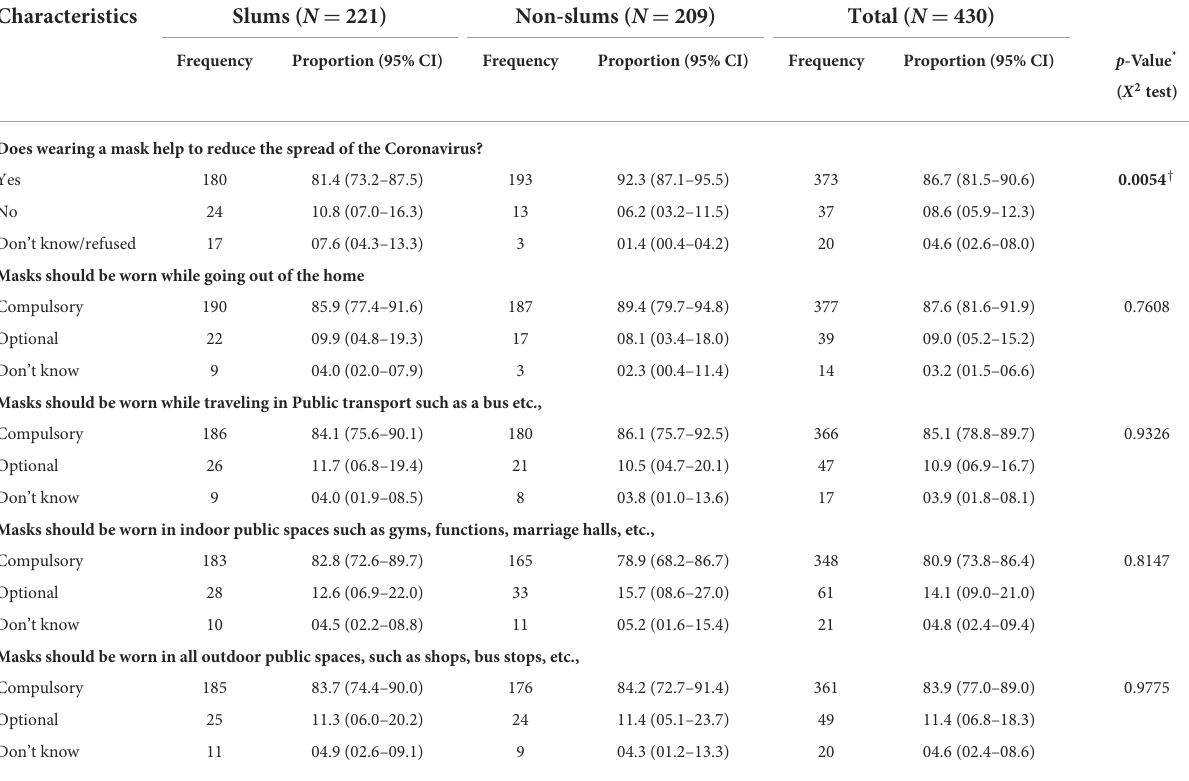
TABLE 2 Knowledge of mask use among the slum and non-slum population, Greater Chennai Corporation, India, March 2021 ( N = 430).